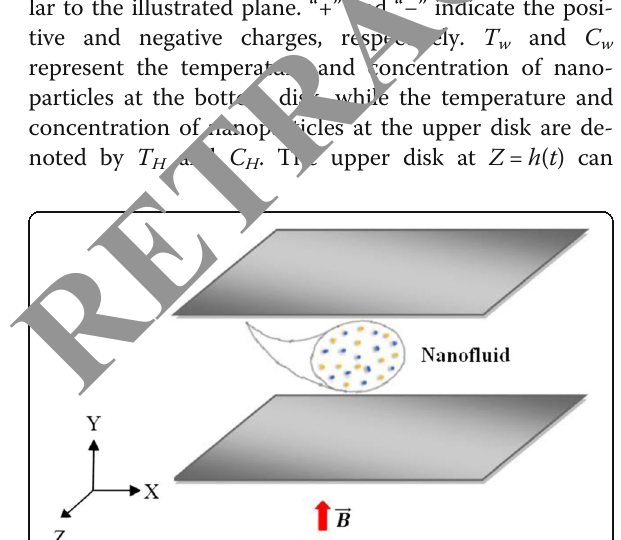
Fig. 1 Schematic of the problem. Nanofluid between parallel plates in the presence of variable magnetic